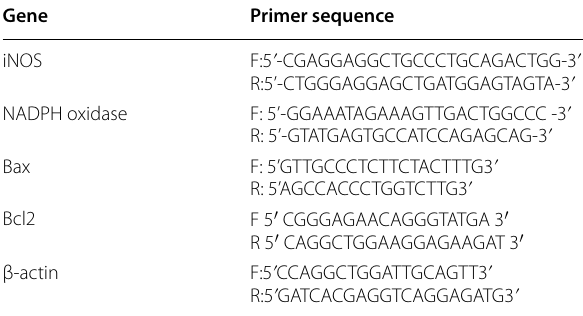
Table 1 List of primers used in PCR Gene Primer sequence